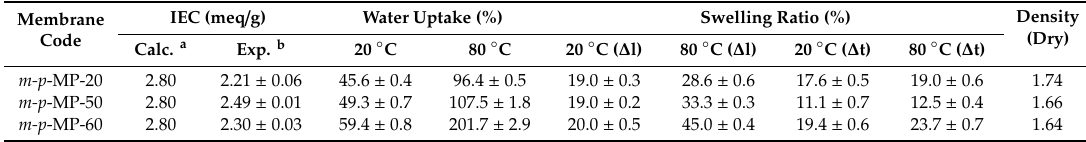
Table 1. Ion exchange capacity (IEC), water uptake, swelling ratio, and density of the m-p -MP-y membranes. IEC (meq / g) Water Uptake Membrane Code